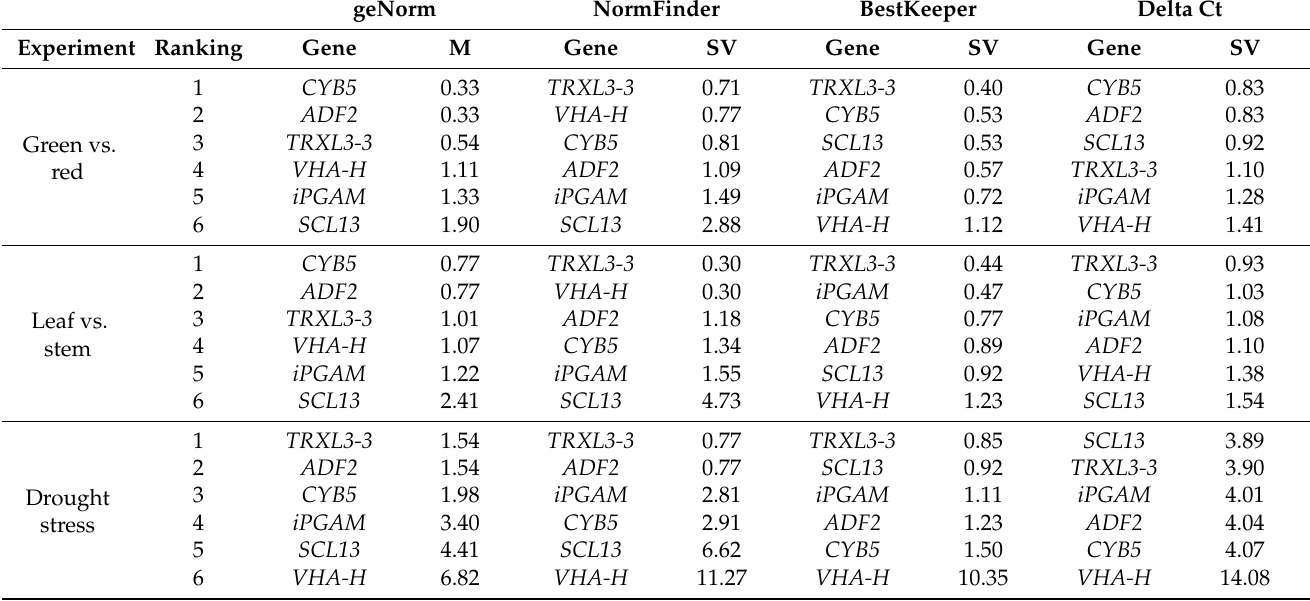
Table 3. Stability values of each candidate reference gene (RG) obtained with geNorm (M), NormFinder, and BestKeeper algorithms, and the Delta Ct method (SV) in three different experiments: green vs. red, leaf vs. stem, and drought stress. geNorm NormFinder BestKeeper Delta